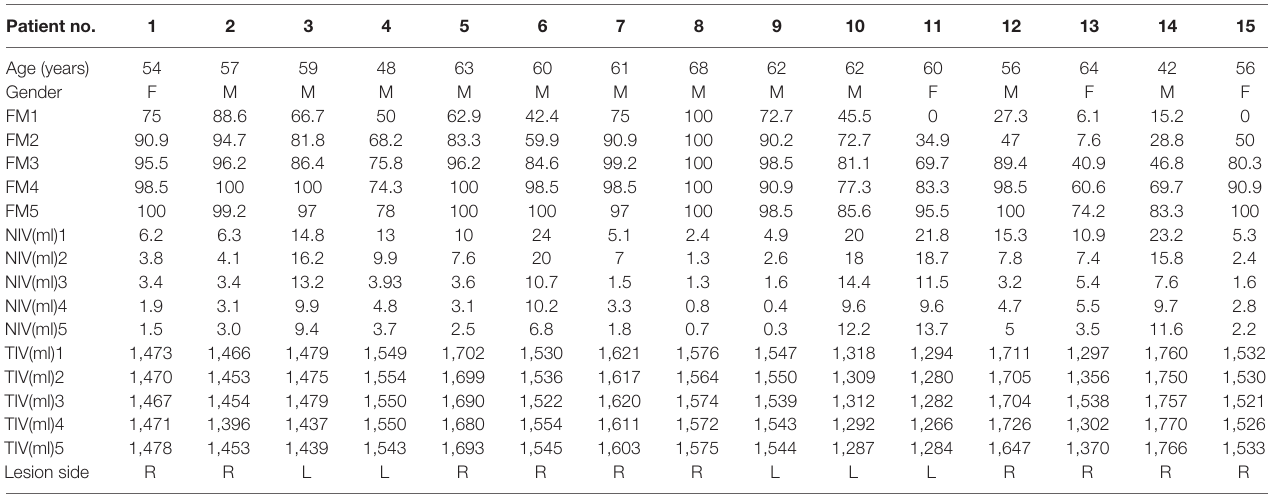
TaBle 1 | Demographic features and clinical data of the PI group. Patient